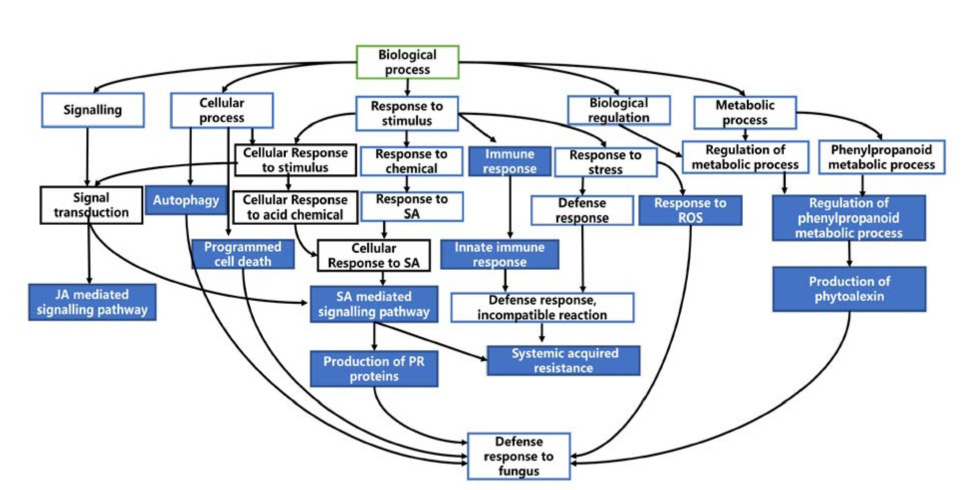
Fig. 8. Directed acyclic graph for biological processes related to defence in